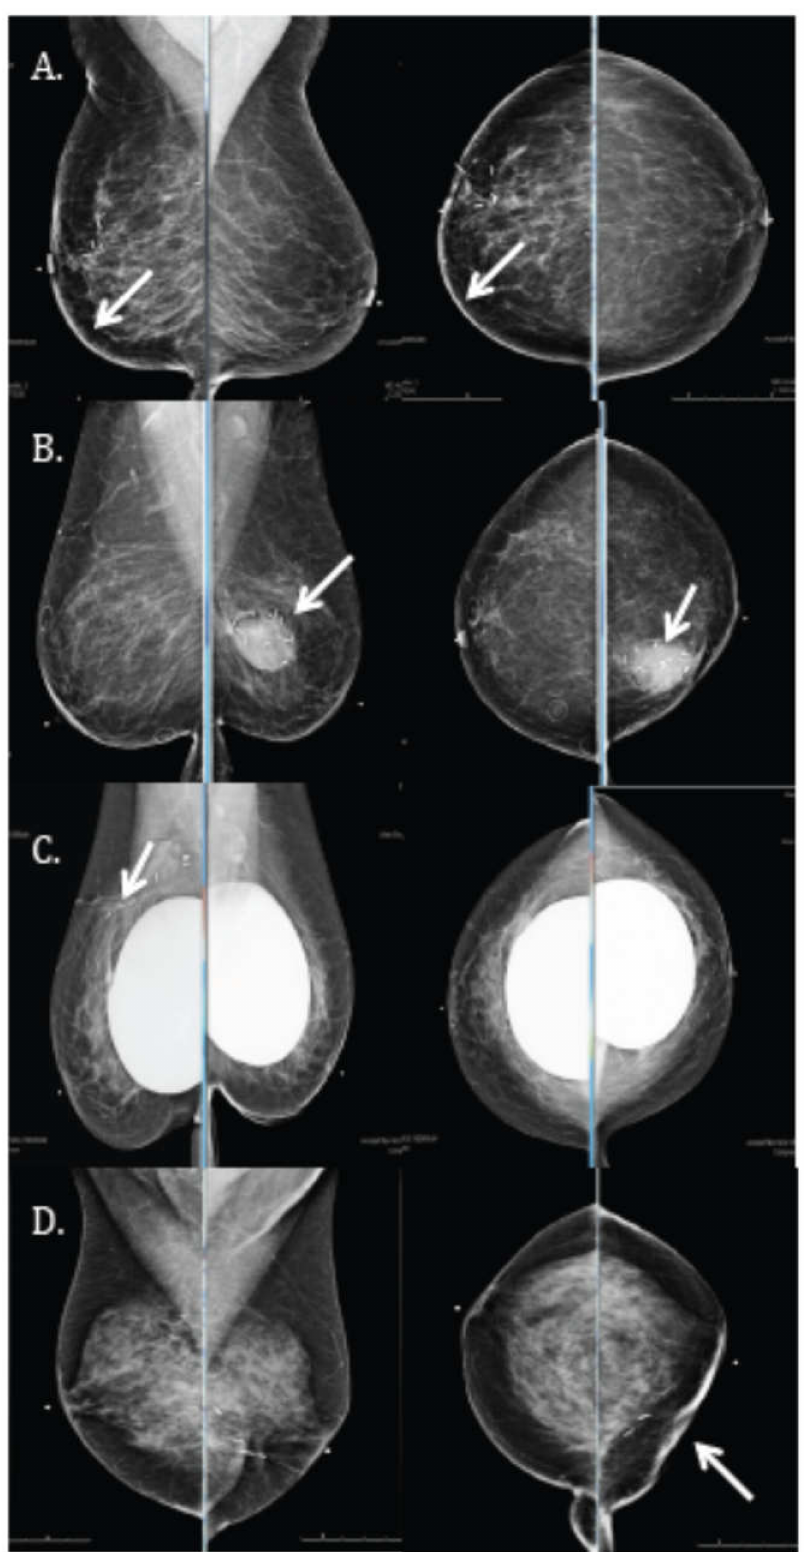
Figure 5. Six-month follow up mammograms showing (arrows) medio-lateral and cranio-caudal views of ( A ) skin thickening; ( B ) seroma/hematoma; ( C ) fat necrosis, and ( D )